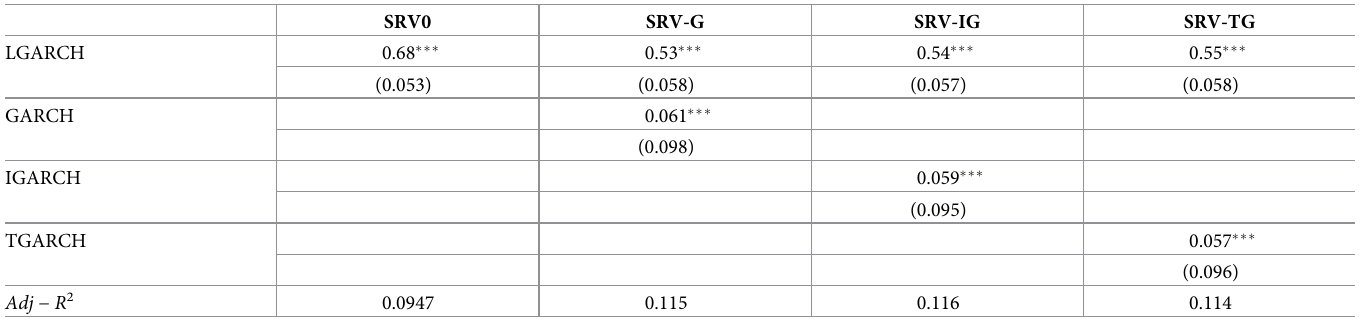
Table 9. Regression results for simplified realized variance (out-of-sample). This table reports the Mincer-Zarnowitz regression result for the model performance com- parison regarding the out-of-sample simplified realized variance. SRV0 represents the single variable regression for our model only, SRV-G represents the model 1 is our model and model 2 is GARCH model defined in Eq (12); SRV-IG represents the model 1 is our model and model 2 is IGARCH model defined in Eq (12); SRV-TG repre- sents the model 1 is our model and model 2 is TGARCH model defined in Eq (12). � , �� , ��� indicate statistical significance at 10%, 5% and 1% levels,